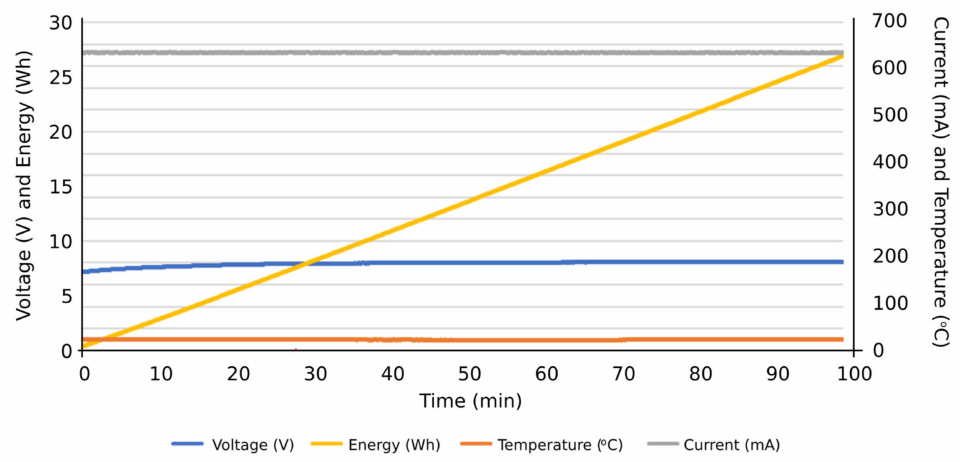
Figure 14. Results of a charging cycle at constant intensity of 500 mA. Individual cell with a threshold voltage of 8 V.